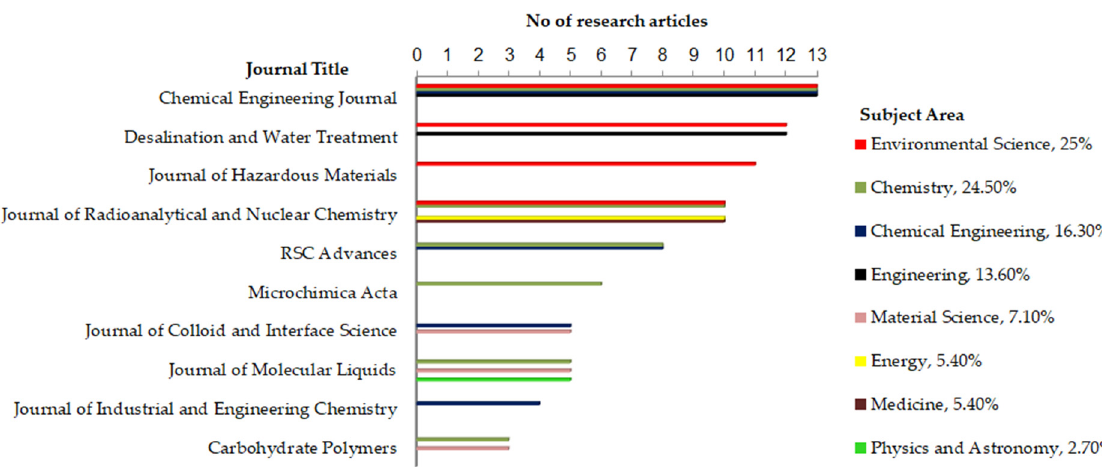
Figure 2. Ranking of top 10 journals: No of articles and relevant subject areas, with percentages of articles within each subject area.